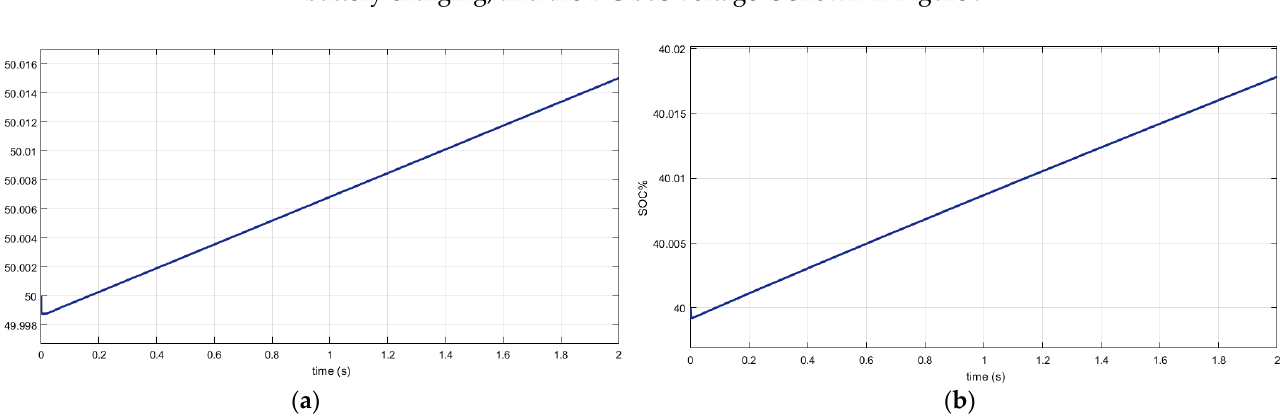
Figure 8. EV and ba tt ery charging from PV. ( a ) EV SOC. ( b ) ba tt ery SOC. Figure 8. EV and battery charging from PV. ( a ) EV SOC. ( b ) battery